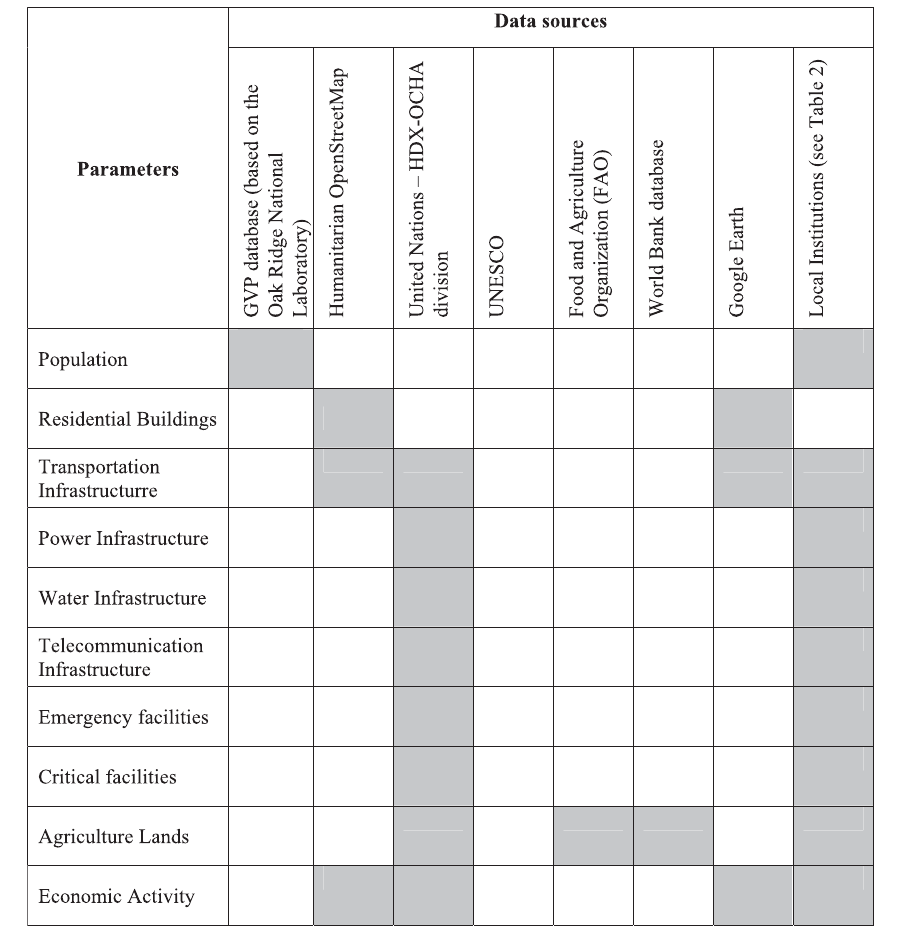
Frontiers in Earth Science |